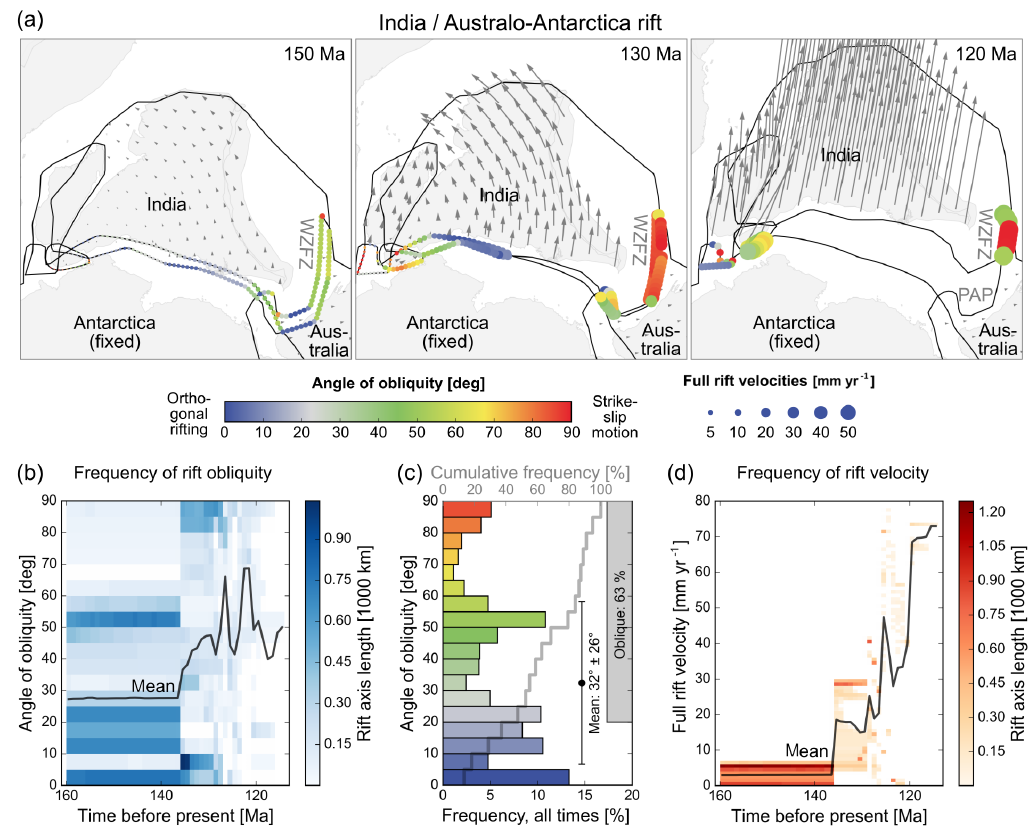
Figure 5. India / Australo-Antarctica rift. Rift obliquity is dominated by two major rift trends: the low-obliquity India-Antarctica branch and the highly oblique India-Australia branch. For simplicity, we neglect low-velocity relative motion between Antarctica and Australia, which will be discussed in Fig. 6. WZFZ: Wallaby–Zenith Fracture Zone, PAP: Perth Abyssal Plain. For explanation of symbols and diagrams see caption of Fig.